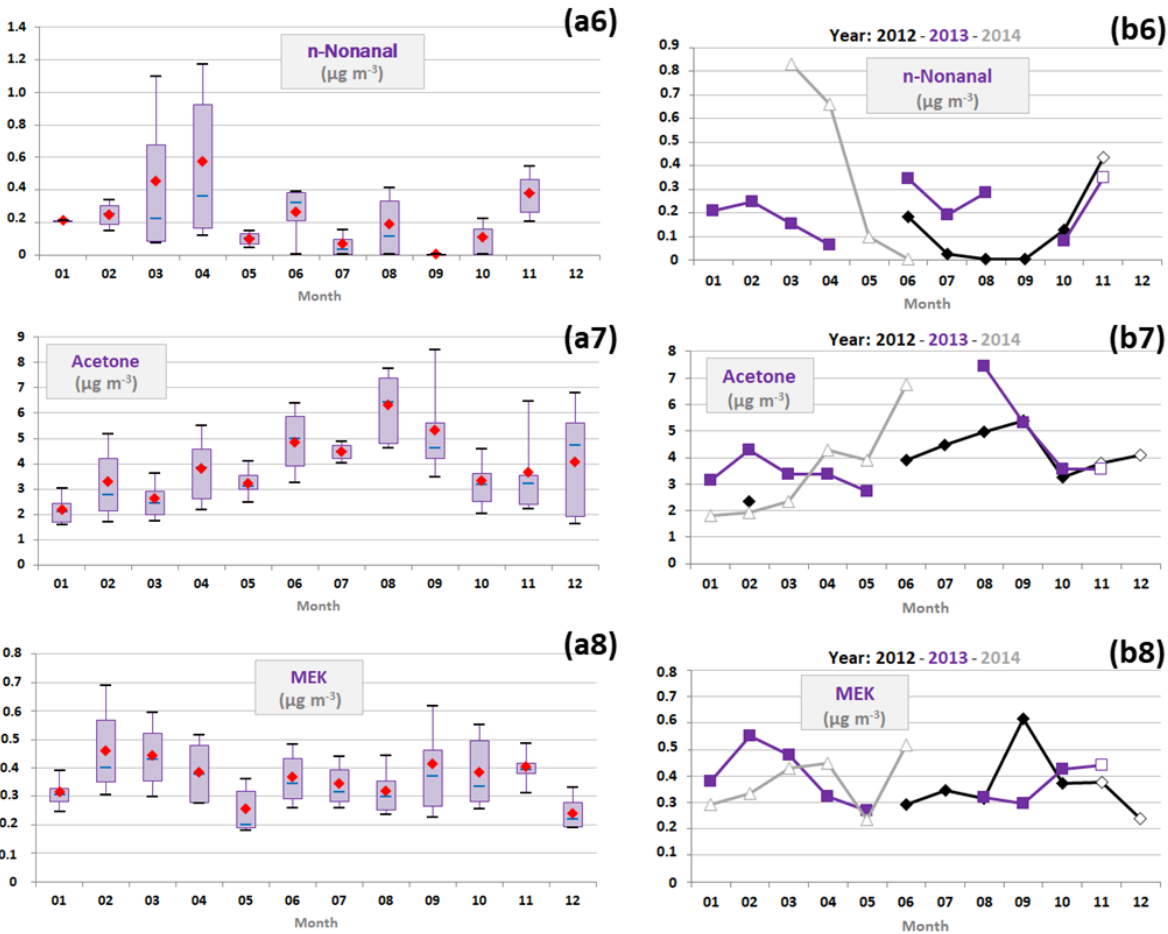
Figure 6. (a) Monthly variations in a selection of oxygenated VOC concentrations (expressed in µgm − 3 ) represented by box plots; the blue solid line, the red marker, and the box represent the median, the mean, and the interquartile range of the values, respectively. The bottom and top of the box depict the first and third quartiles and the ends of the whiskers correspond to the first and ninth deciles. (b) Their monthly average concentrations as a function of the year; full markers indicate months when VOC samples were collected from 12:00 to 16:00UTC and empty markers those when VOC samples were collected from 09:00 to